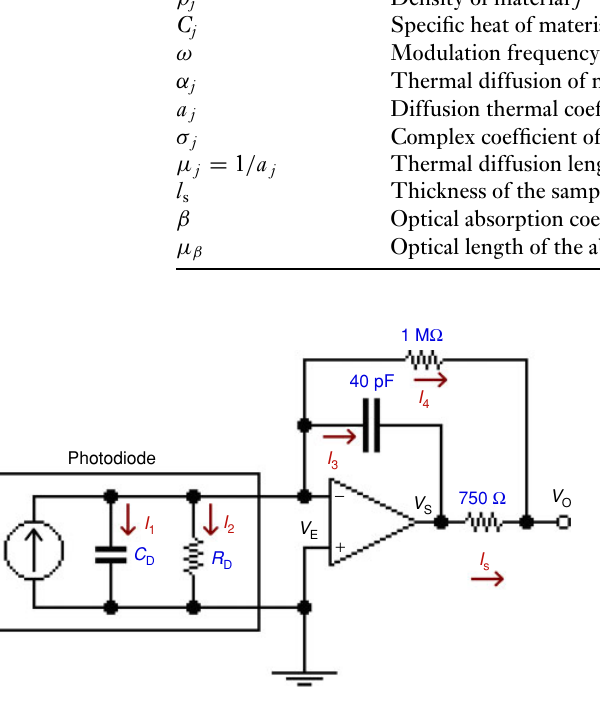
Figure 2 Model of the photodiode and operational amplifier.